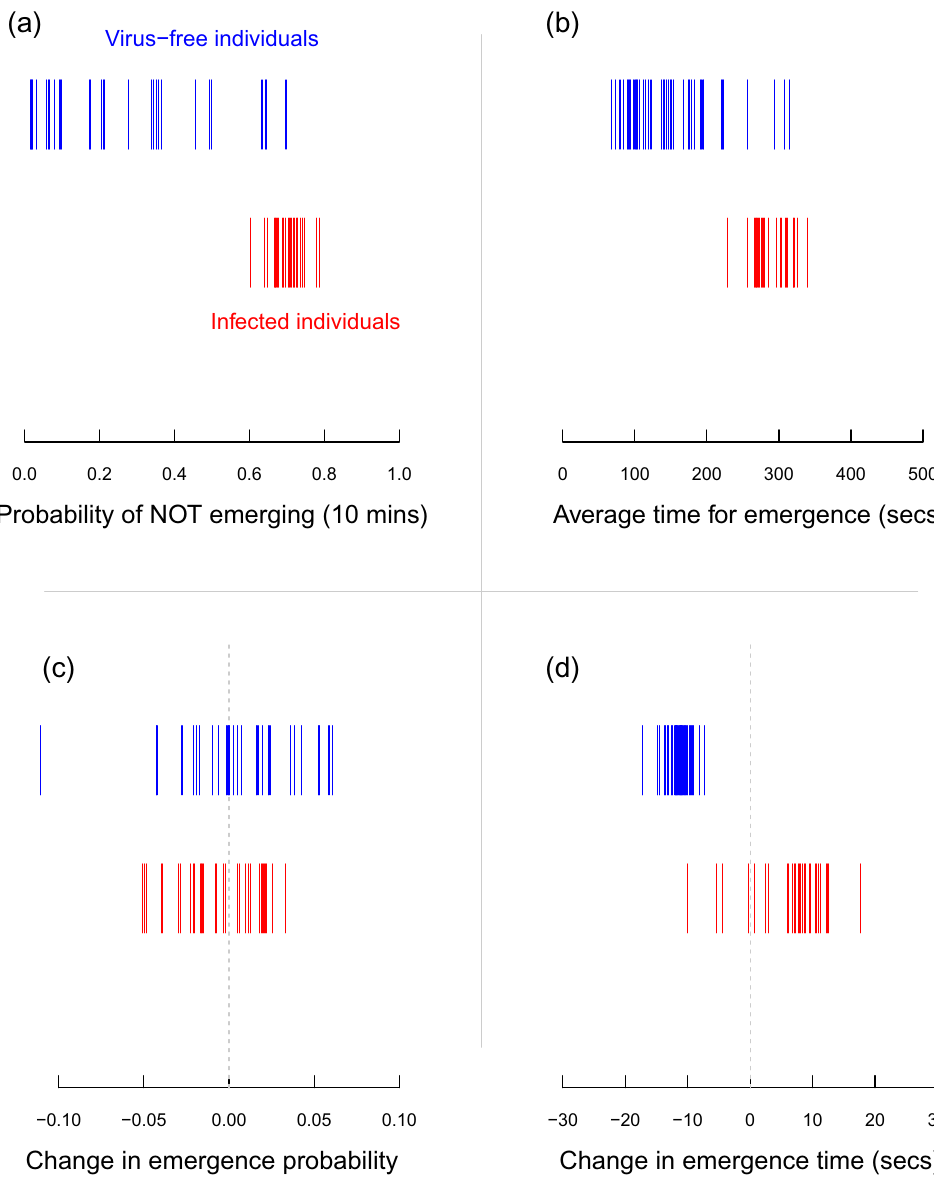
Figure 3. Estimated mean ‘personality scores’ for each individual cricket (vertical lines) for virus-free individuals (blue) and infected individuals (red), derived from the four model parameters that included an individual-level random effect: ( a ) binomial intercept, ( b ) continuous intercept, ( c ) binomial slope, and ( d ) continuous slope. See Table 1 for estimates of the raw parameters, Fig. 1 and Appendix S1 for a formal model description, and Fig. 4 for the individual personality scores to be disaggregated by